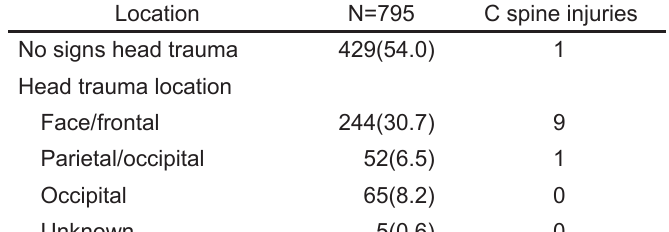
Table 1. Baseline characteristics of geriatric patients presenting to